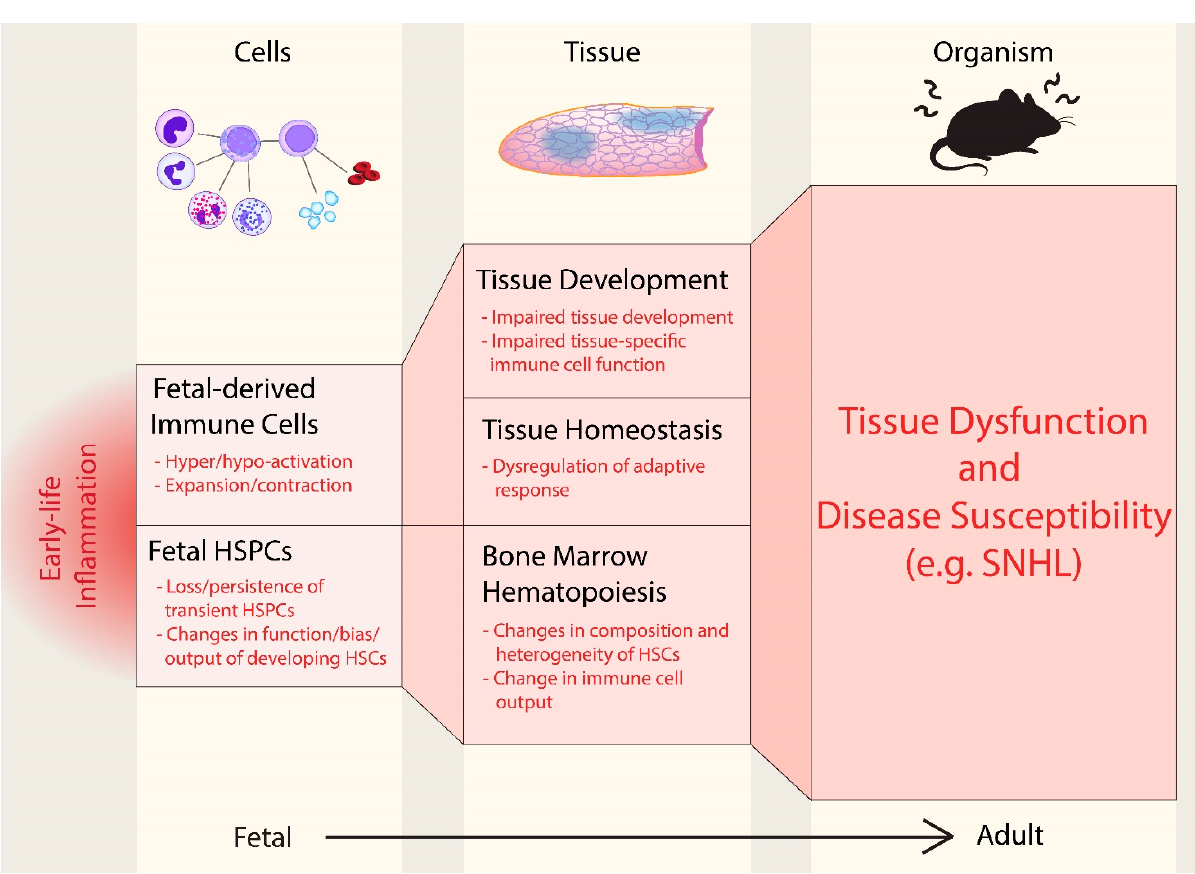
Figure 1. Early life inflammation as a driver of disease susceptibility. Perinatal inflammation can drive lasting changes to immune function from fetal development onwards by perturbing immune function at the cellular, tissue, and whole organism level. Impaired development of fetal-derived immune cells that influence tissue development and homeostasis can ultimately impair tissue function. Specifically, fetal-derived immune cell compartments can either be expanded or reduced by inflammation, or cells can by hyper- or hypo-activated. Perturbing the establishment and function of developing fetal hematopoietic stem and progenitor cells (HSPCs) by inducing loss or persistence of transient HSPCs, or shaping function and output of developing HSCs may also result in lasting changes to the composition or output of the adult hematopoietic stem cell (HSC) compartment. Ultimately, the effects of perinatal inflammation on both developing HSPCs and fetal-derived immune cells may reshape the trajectory of postnatal immunity and susceptibility to disease by impinging on tissue immunity and/or the output of the hematopoietic system.